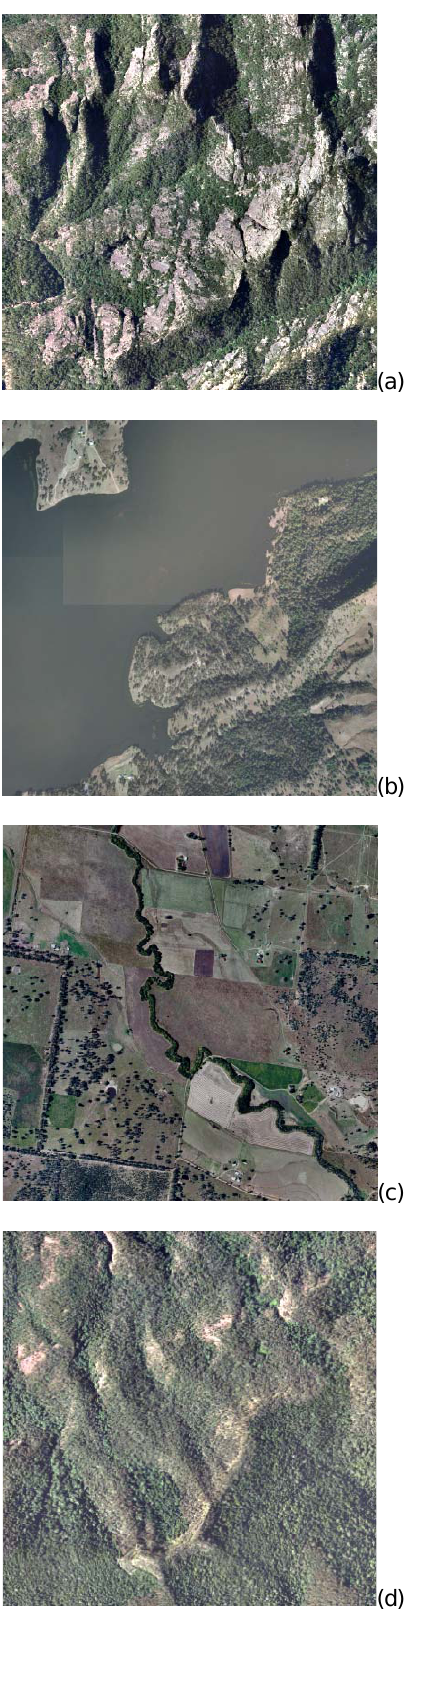
Figure 1 – Aerial view (left) and c corresponding elevation images (right) of the test sites. The obtained from grid DEMs of 1 me etre. The elevations are in metres. (a) peaks; (b) lake; (c) vall